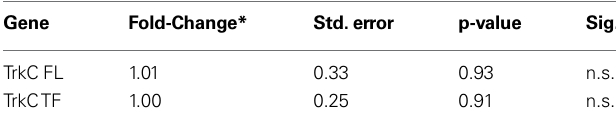
Table 2 | Quantitative RT-PCR analysis of TrkC full-length isoform (FL) and TrkC truncated isoform